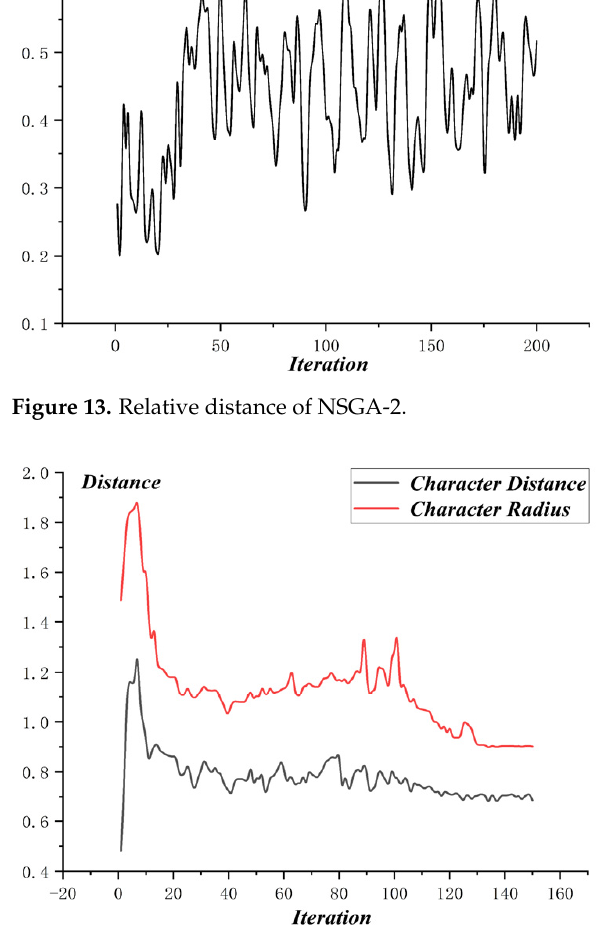
Figure 16. Optimization process of MSGWO.